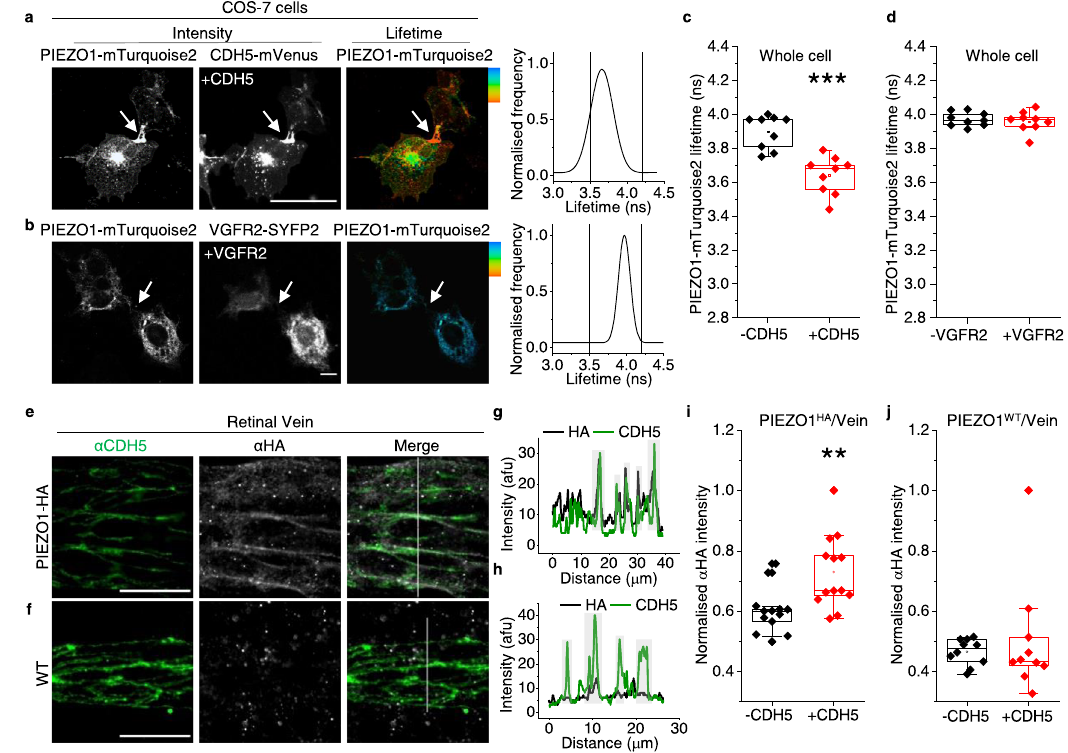
Fig. 5 CDH5 but not VGFR2 partners with PIEZO1. a – d FRET/FLIM images and analysis for COS-7 cells expressing a PIEZO1-mTurquoise2 plus CDH5- mVenus (CDH5-mVenus) or b PIEZO1-mTurquoise2 plus VGFR2-SYFP2. a , b Intensity images (white, high intensity), lifetime images calibrated to the rainbow scale indicated at the top corner (3.5 – 4.2 ns) and graphs of the lifetime distributions in which grey vertical lines indicate the rainbow scale limits. Scale bars, 50 µ m, apply to all images. c , d Box plot summary peak whole cell lifetime data for the experiment types of a and b . 3 independent experimental repeats for PIEZO1-mTurquoise2 alone (-CDH5/VGFR2, black) and PIEZO1-mTurquoise2 plus CDH5-mVenus (*** P = 7.68 ×10 − 4 ) or VGFR2-SYFP2 ( P = 0.72393) ( + CDH5/VGFR2, red). Superimposed data points are average lifetime values for individual images ( − CDH5, N = 9; + CDH5, N = 9; − VEFGR2, N = 9; + VGFR2, N = 9). e – j Images and image analysis for retinal veins of HA-PIEZO1 mice (PIEZO1 HA ) or wild-type (WT) mice (PIEZO1 WT ) immuno-stained with α CDH5 antibody (green) and α HA antibody (grey). e , f Representative images for α CDH5 and α HA staining with merger of these images to the right. Scale bars, 20 µ m. g , h are the line-intensity (grey value) plots for the vertical scan lines superimposed on the Merge images of e and f . Green α CDH5, grey α HA. Light grey highlighting indicates cell-cell junctions. i , j Box-plot quanti fi cation of image intensity for e PIEZO1 HA or f PIEZO1 WT retinal veins stained with α HA, shown for junctional regions indicated by α CDH5 staining ( + CDH5) and non-junctional regions ( − CDH5) in arbitrary fl uorescence units (AFU). The intensity of each image was normalised to the image background. ** P = 0.00347. Data are for n = 3 independent experiments. The superimposed data points are the average intensity for individual images, PIEZO1 HA ( − CDH5, N = 13 and + CDH5, N = 13) PIEZO1 WT ( − CDH5, N = 10 and + CDH5, N =